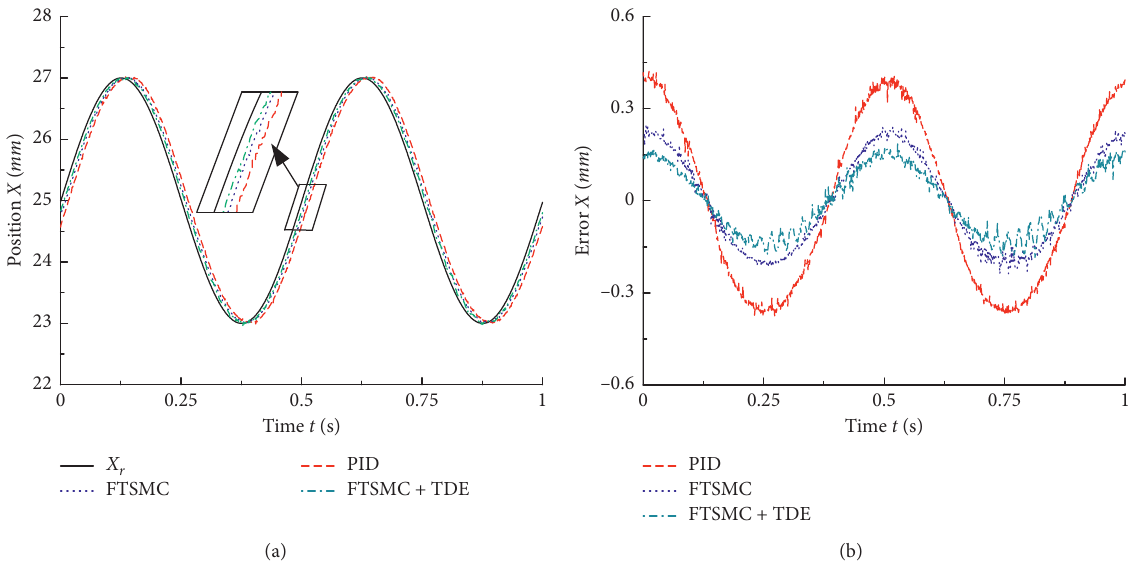
Figure 11: Working condition ④ in Table 4. (a) Position of 2 mm amplitude and 1Hz frequency. (b) Position error of 2mm amplitude and 2Hz